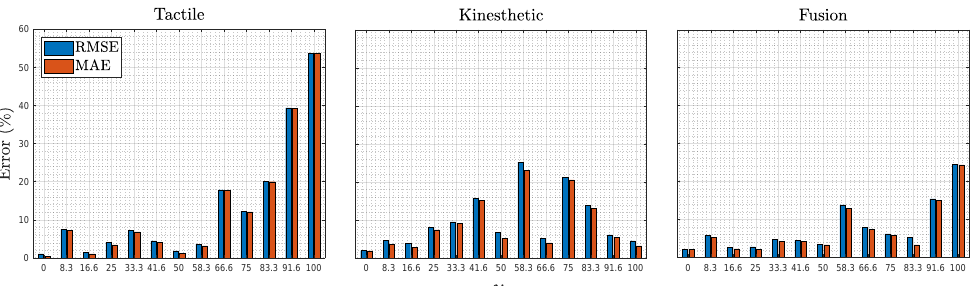
Figure 8. The root mean squared error (RMSE) and the medium absolute error (MAE) achieved for each X % tested. Both errors are presented for the kinesthetic, the tactile, and the fusion neural net-